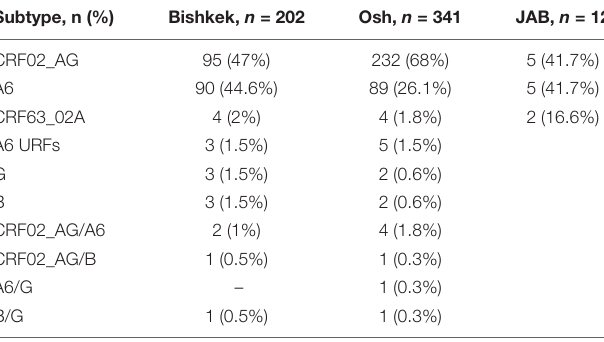
TABLE 2 | Distribution of HIV-1 subtypes by the study